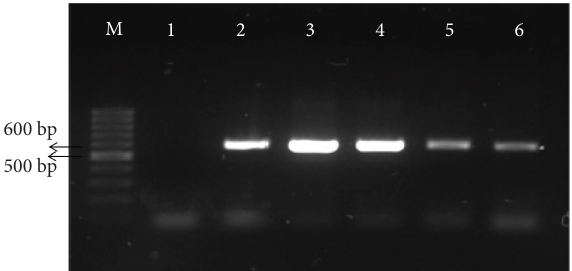
Figure 3: Amplifcation of loop 1 (L1) region of hexon gene of fowl Adenoviruses. Lane M 100bp DNA ladder (Gene Ruler, Termo Scientifc), Lane1: negative control. Lane 2–6: test